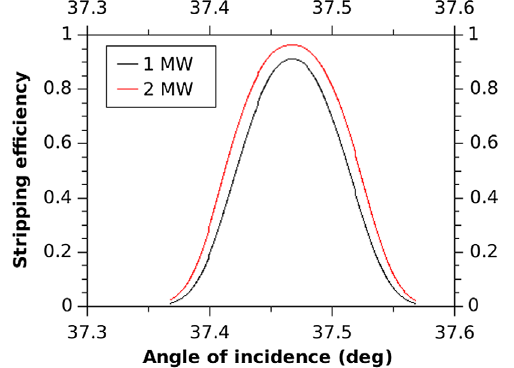
FIG. 11. Peak laser power required for 90% stripping efficiency for different values of D 0